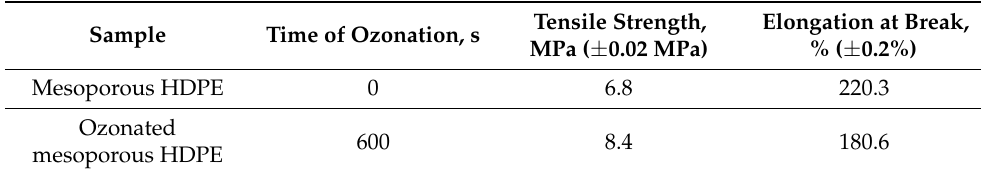
Table 3. Results of the mechanical analysis.